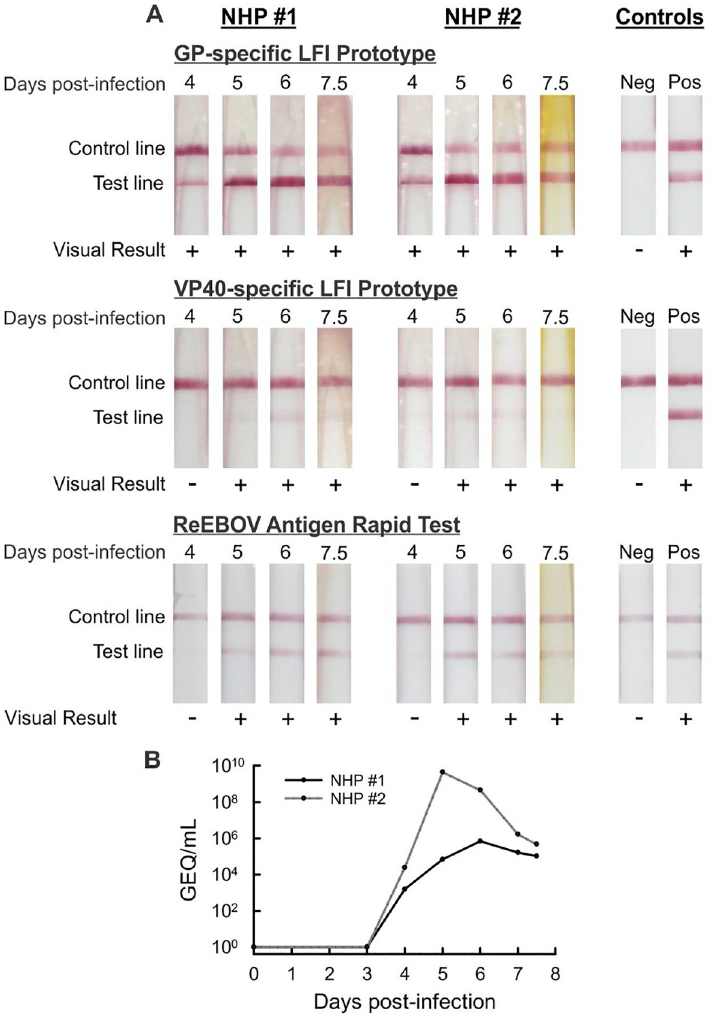
Fig 3. EBOV lateral flow immunoassay (LFI) prototype testing of infected non-human primate (NHP) serum. Panel A–The GP-specific LFI prototype, VP40-specific LFI prototype and ReEBOV Antigen Rapid Test (Zalgen Labs) were tested with serum samples taken 4, 5, 6, and 7.5 days post-infection (DPI) from two EBOV (variant Makona) infected NHPs; positive (+) or negative (-) results are reported below each LFI. Panel B–Quantitative viremia determined via qRT-PCR for 0, 3, 4, 5, 6, 7, and 7.5 days dpi from the same two NHPs; results are reported as genome equivalents (GEQ) per mL of